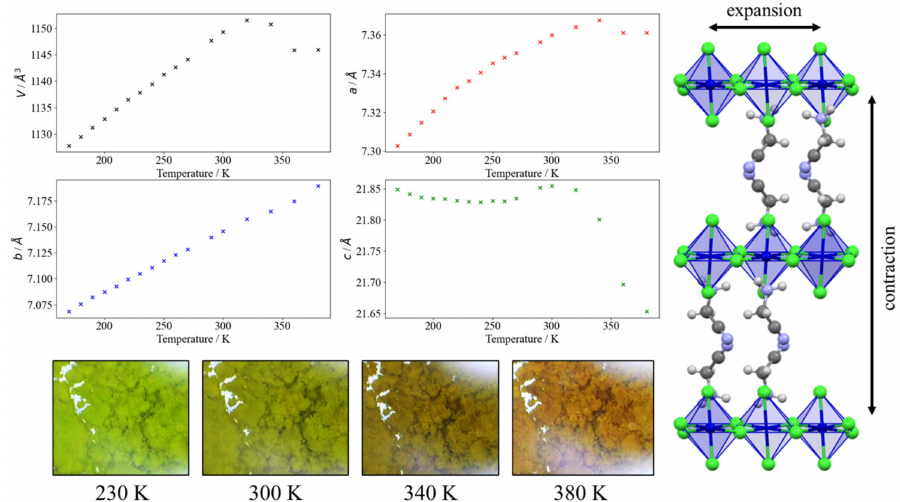
Figure 4. Unit cell parameters of aacn 2 CuCl 4 as a function of temperature. The parameters follow a linear trend, up to ~320 K, after which cell volume, and axes a and c decrease. This can be interpreted as the layer distorting itself, and organic cations coming closer together at high